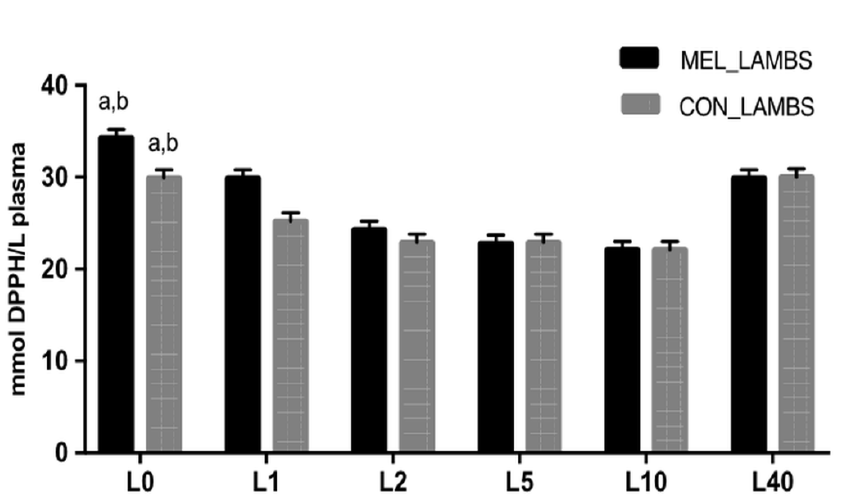
Figure 2. Least squares means ± SEM of total antioxidant capacity (mmol DPPH/L plasma) of lambs’ plasma, in control group (CON) and in melatonin group (MEL), at birth (L0) and on days 1 (L1), 2 (L2), 5 (L5), 10 (L10) and 40 (L40) of their life, p < 0.005, a: among the two groups, b: within time.